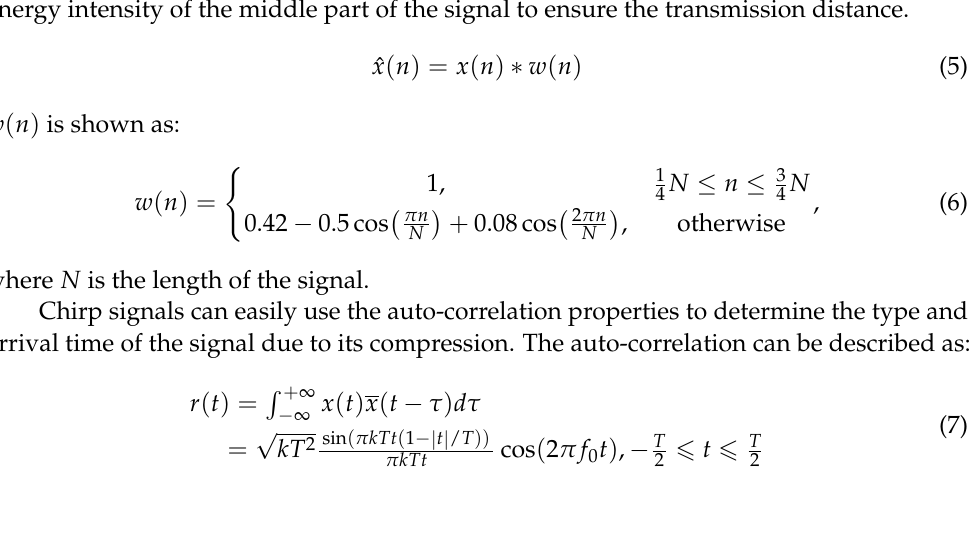
Figure 7. ( a ) Spectrum and ( b ) waveform of the Chirp